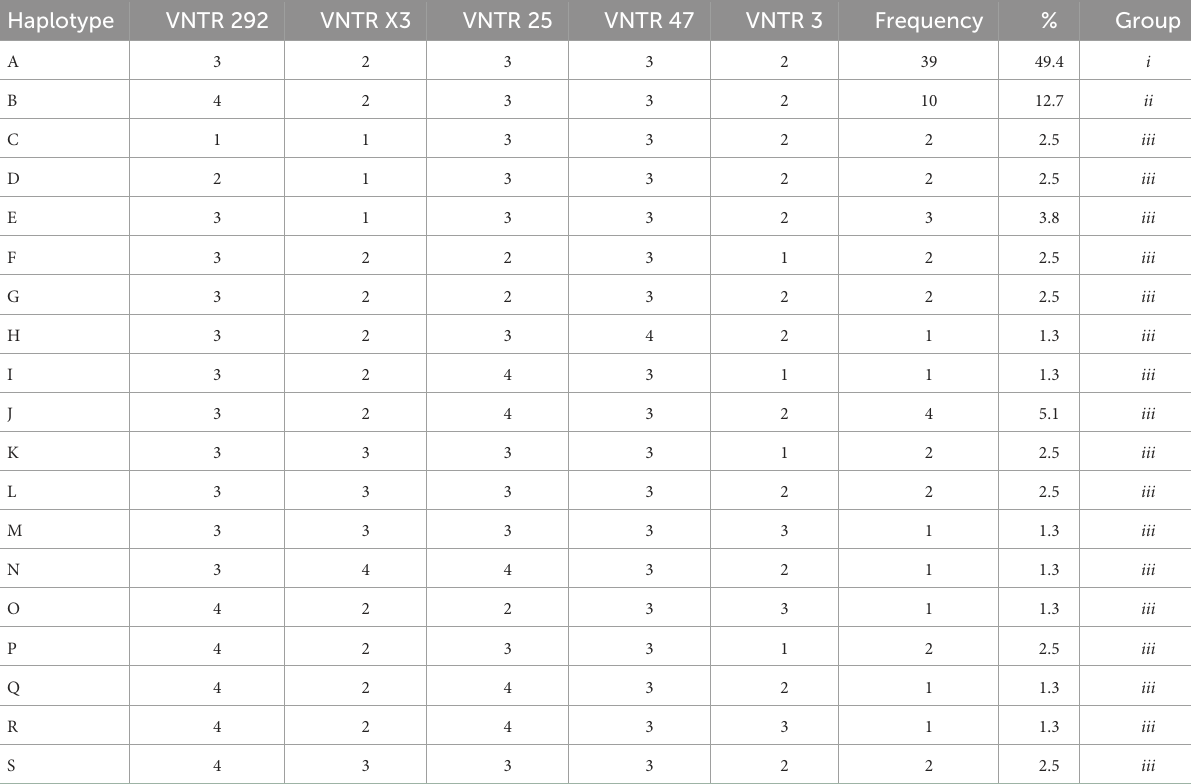
TABLE 2 Copy numbers for the five MIRU-VNTR markers used for the strain-typing of Mycobacterium avium subspecies paratuberculosis (MAP) isolates.